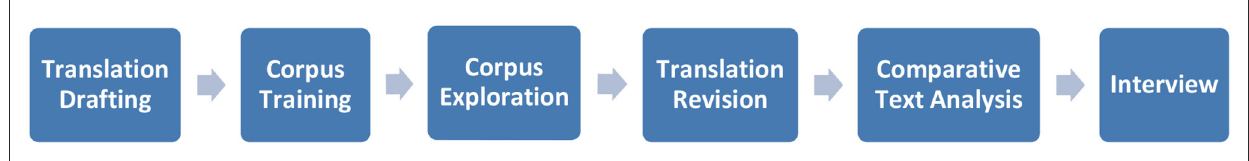
FIGURE1 The procedure of DDL-based self-translation of academic